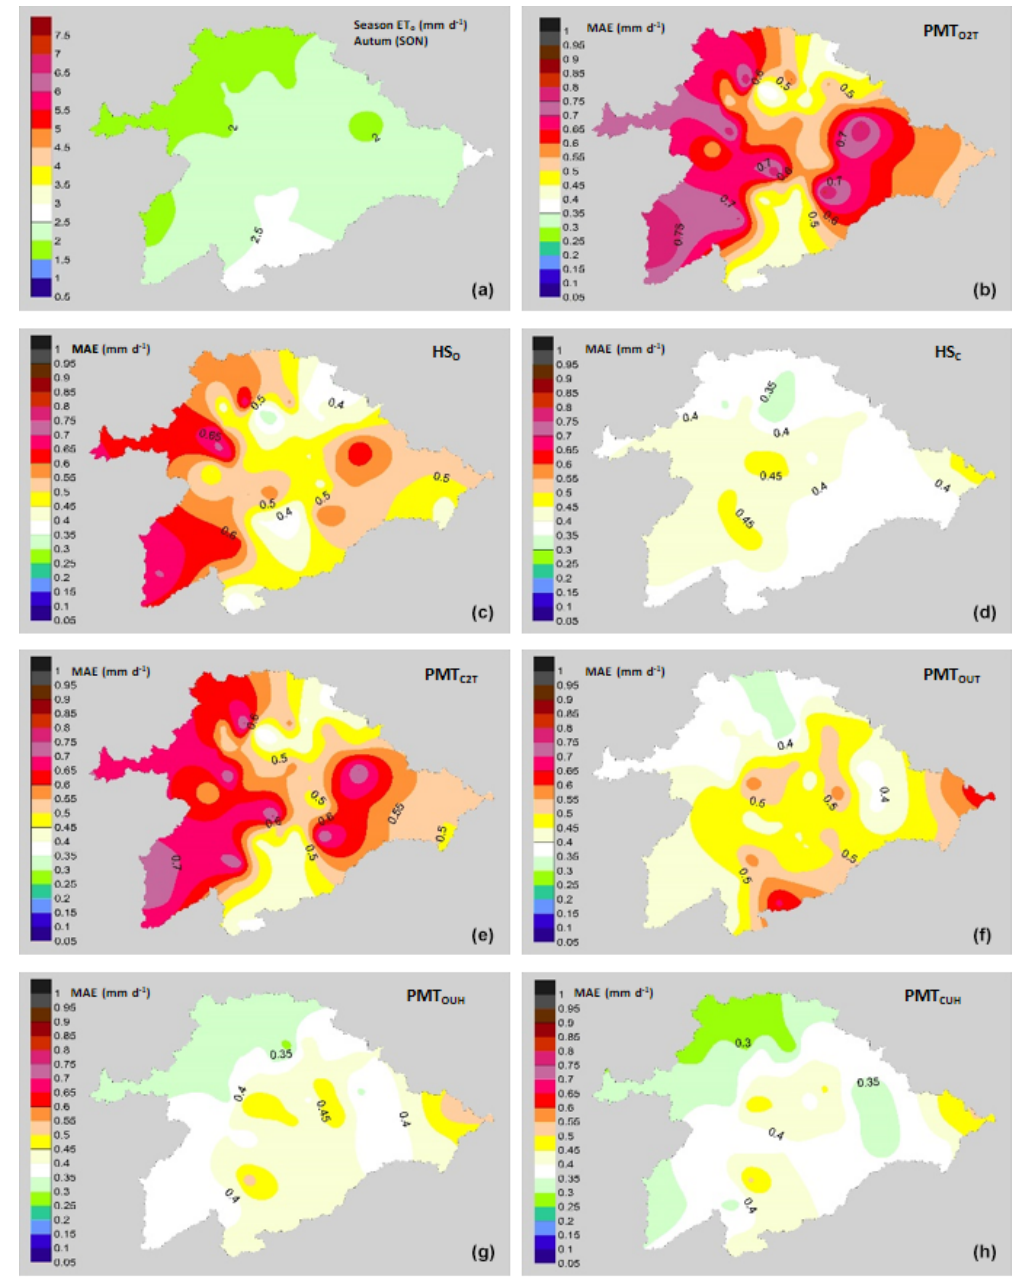
Figure 7. Performance of the models with an autumn focus (September, October and November). (a) Average values of ET o (mmd − 1 ) in autumn. Mean values of MAE (mmd − 1 ): (b) PMT O2T model, (c) H O model, (d) H C model, (e) PMT C2T model, (f) PMT OUT model, (g) PMT OUH model and (h) PMT CUH